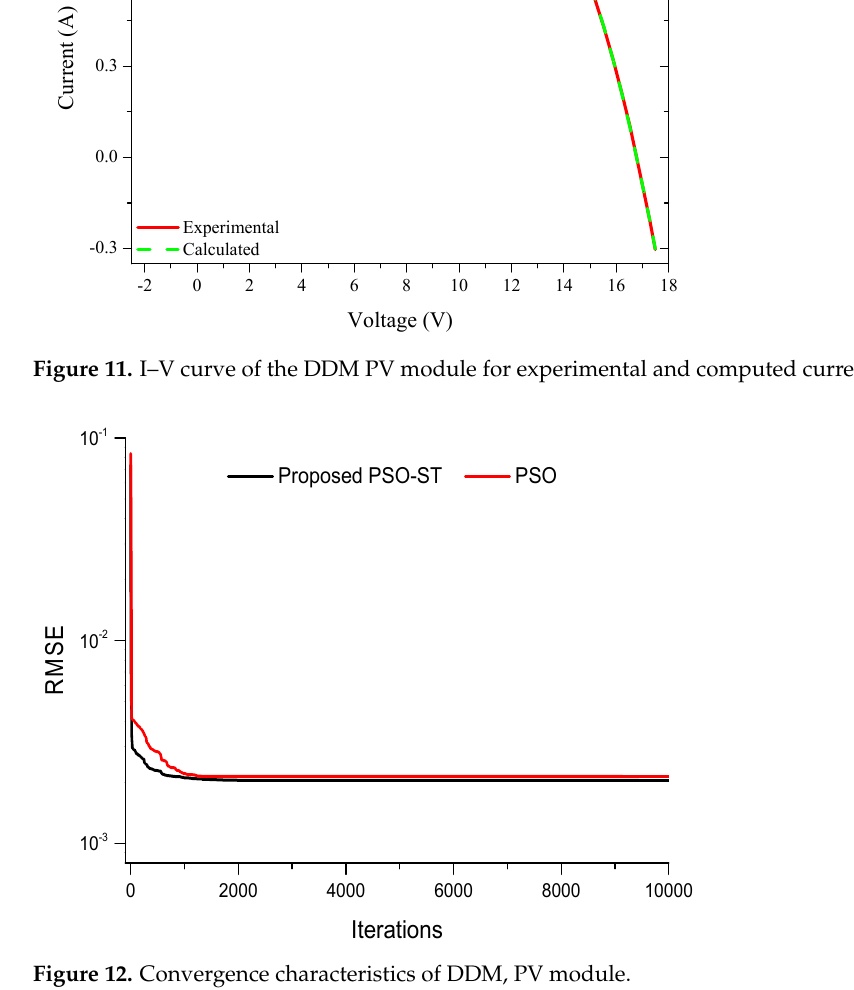
Table 11. JKM330P-72 DDM PV module statistical results for all respective curves. Experimental